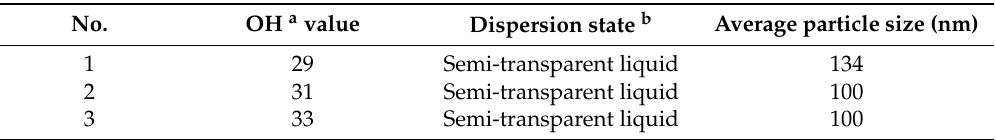
Table 4. The stability and particle size of the aqueous PBA-based